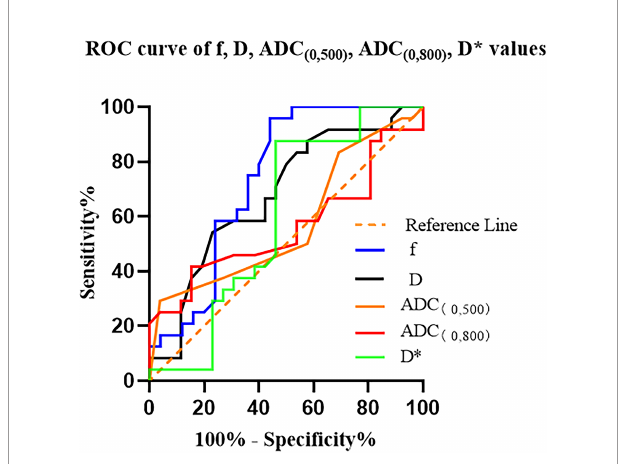
FIGURE 6 | ROC curves for the ADC (0, 500) , ADC (0, 800) , D, D*, and f values for differentiating high- and low- fi brosis group PDAC D* is a speci fi c parameter value of the IVIM, where * has no speci fi c